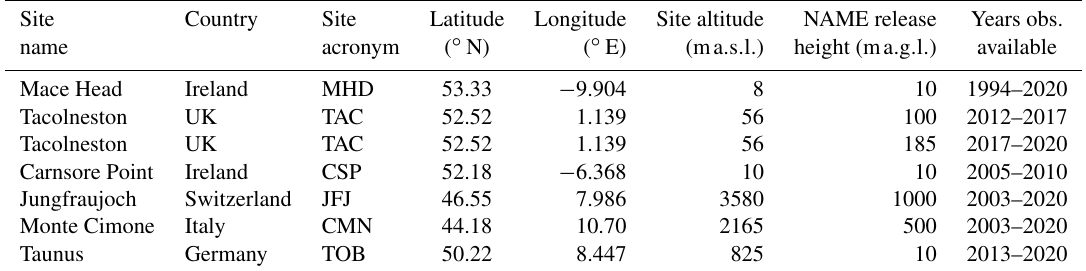
Table 2. Observation site information. Note that the NAME release heights are dependent on the height of the observation inlet above ground, and site altitude is given in metres above sea level (ma . s . l .